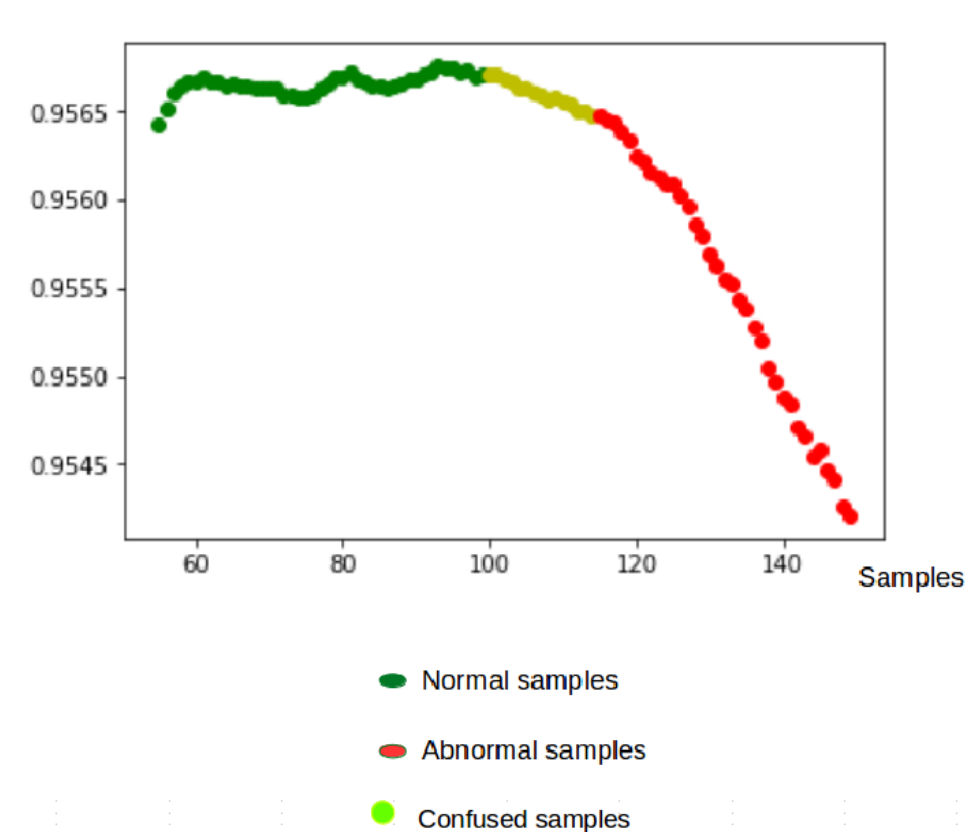
Figure 10. Mean of features at the testing